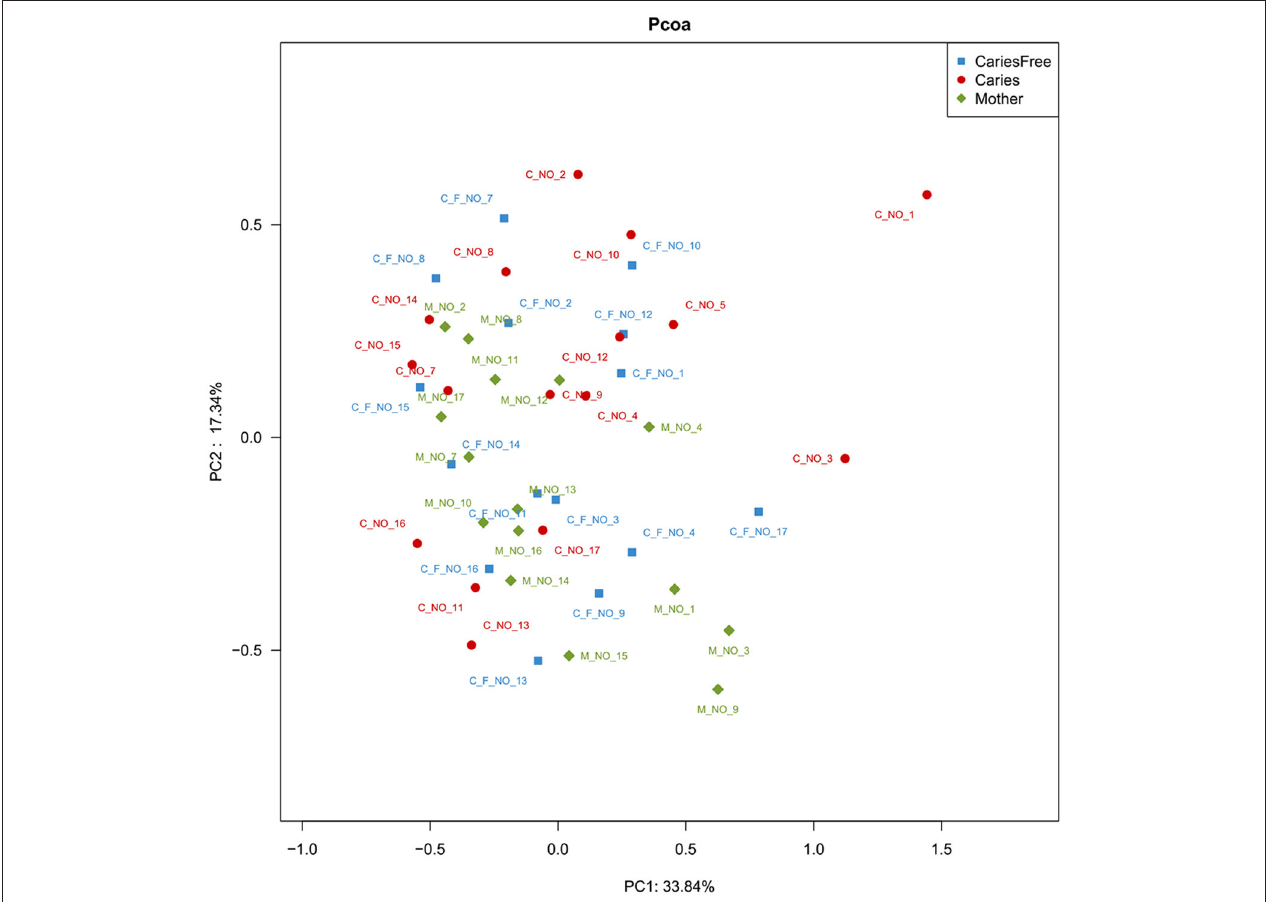
FIGURE 5 | PCoA analysis of the supragingival plaque bacterial communities. The analysis was based on the Bray-Curtis similarity matrix constructed using the square-root-transformed OTU. The percent of variation explained is given behind of the value of